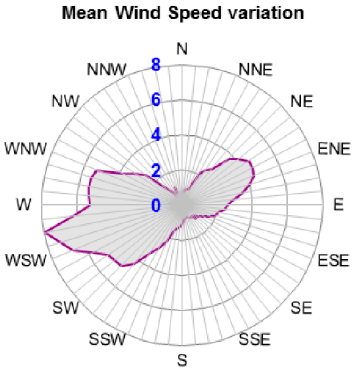
Figure 5. Wind Rose main results regarding the mean wind speed for the Um Al Rumman meteorological mast .